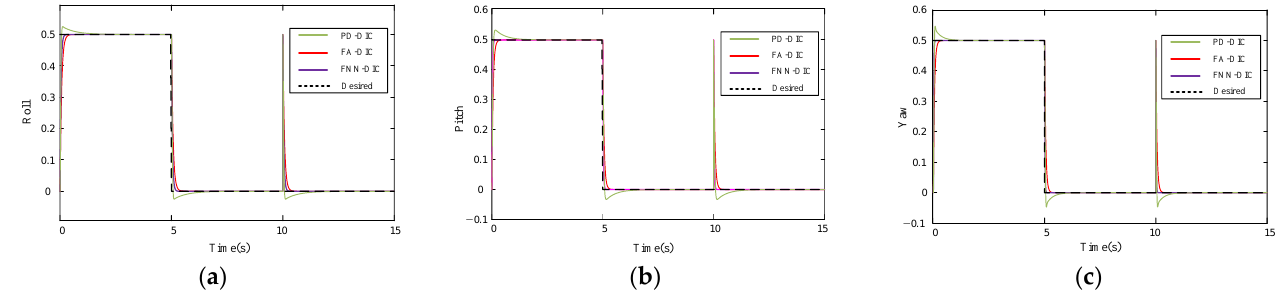
Figure 7. The control effect of the three kinds of controllers in a stable atmosphere: ( a ) roll channel, ( b ) pitch channel, and ( c ) yaw channel. Table 3. Performance metrics of controllers in the altitude channel.